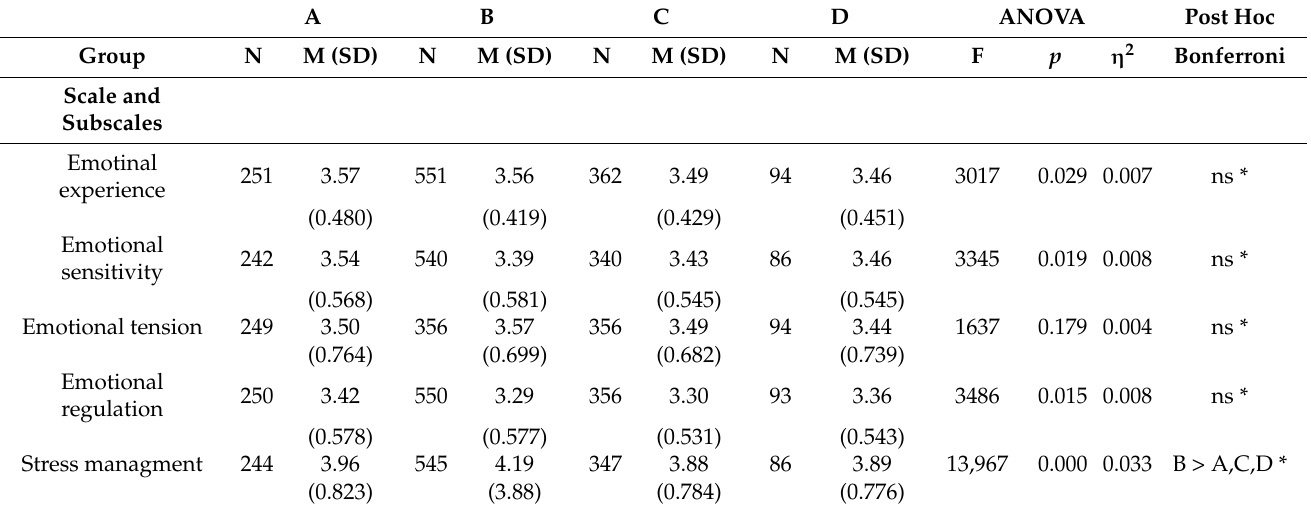
Table 4. Descriptive statistics and analyses of variance for the emotional experience scale and its subscales according to the parents’ employment